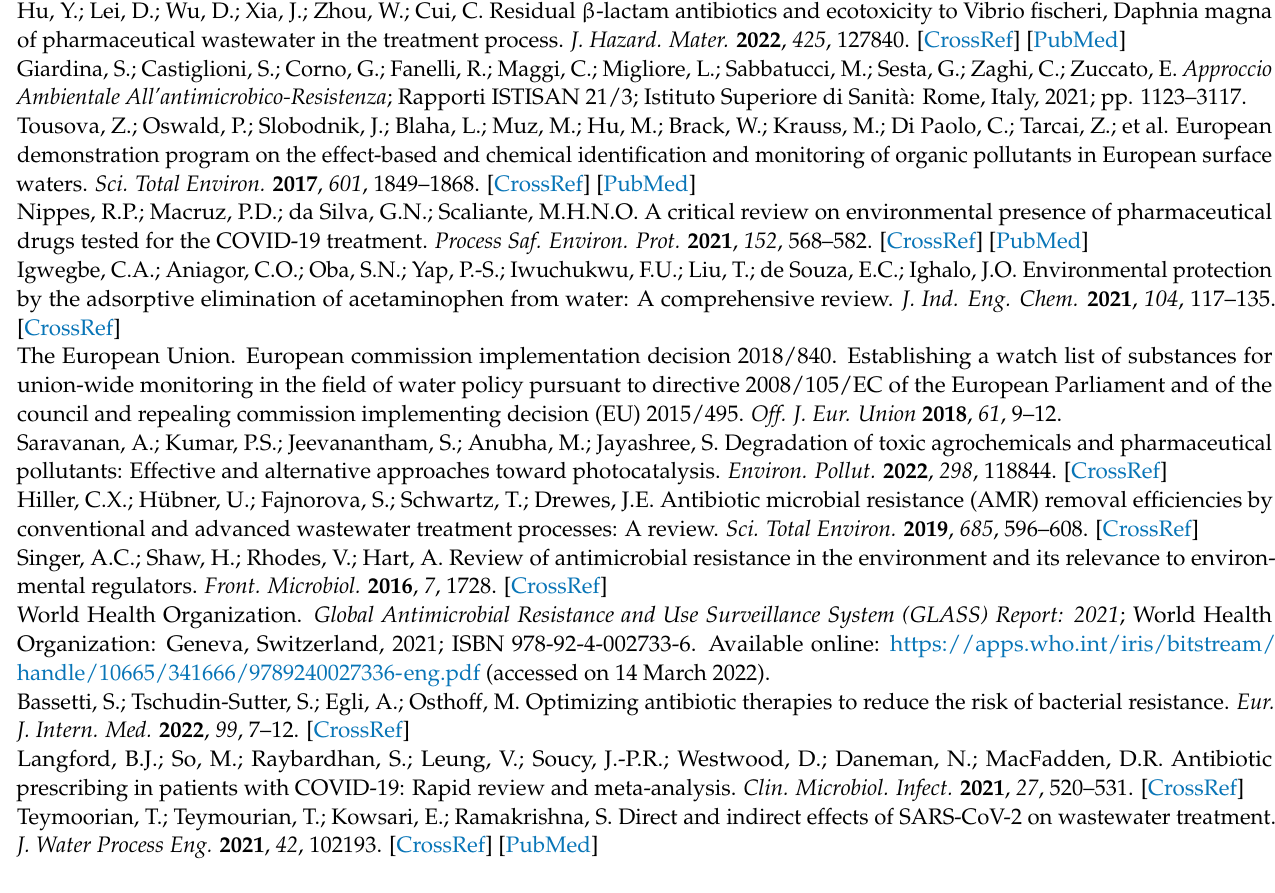
Figure S5: Acinetobacter baumannii test. AMX (plate 1) and PAM (plate 6) before degradation; AMX- TiO 2 (plate 3) and AMX-CS/Ag1000/TiO 2 (plate 5) after degradation; Table S1: Antibiotic activity of PhC degradation products after photodegradation experiments compared to that of the original drugs. The presence/absence of the inhibition zone is measured by its diameter (mm). R indicates a resistant